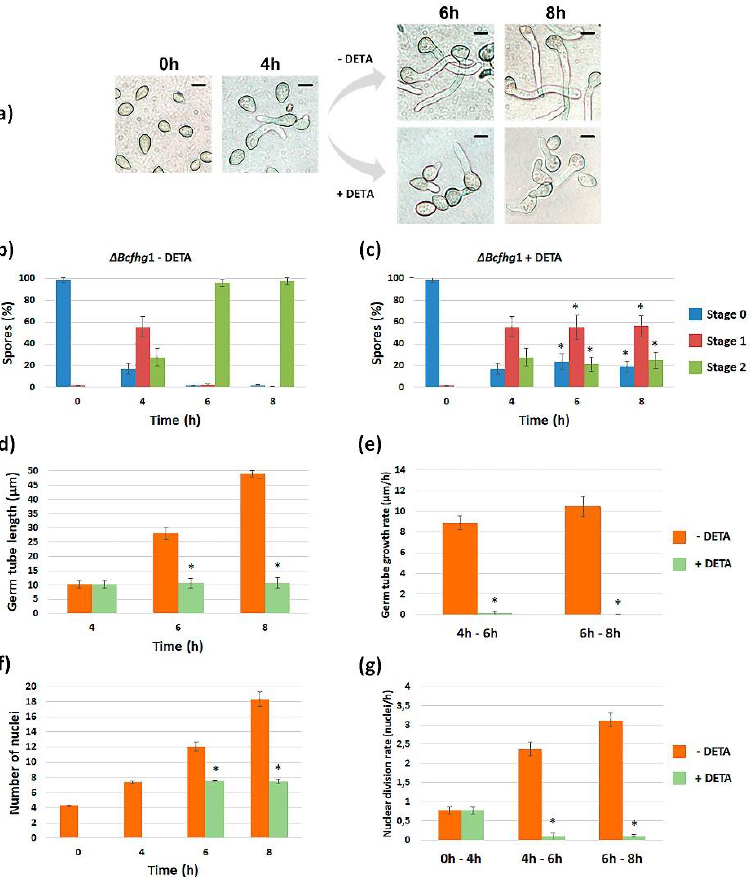
Figure 6. Effect of the addition of 250 µ M DETA to ∆ Bcfhg 1 spores once the germination program has been launched. ( a ) Experimental set-up and representative images taken at indicated time points and conditions. ( b , c ) Percentages of spores in the different stages of development (0, 1 and 2) at the indicated time points in the absence ( b ) and presence ( c ) of 250 µ M DETA. ( d ) Average germ tube length at the indicated time points. ( e ) Germ tube growth rate at 4–6 and 6–8 h. ( f ) Average number of nuclei in spores and germ tubes at the indicated time points. ( g ) Average nuclear division rate at 4–6 and 6–8 h. The data present the means of three replicates ± SD ( n ≥ 100 each). (* indicates significant differences at p < 0.05—Student’s t -test—in the presence of 250 µ M DETA and its reference situation in the absence of DETA.) Scale bars, 10 µm.